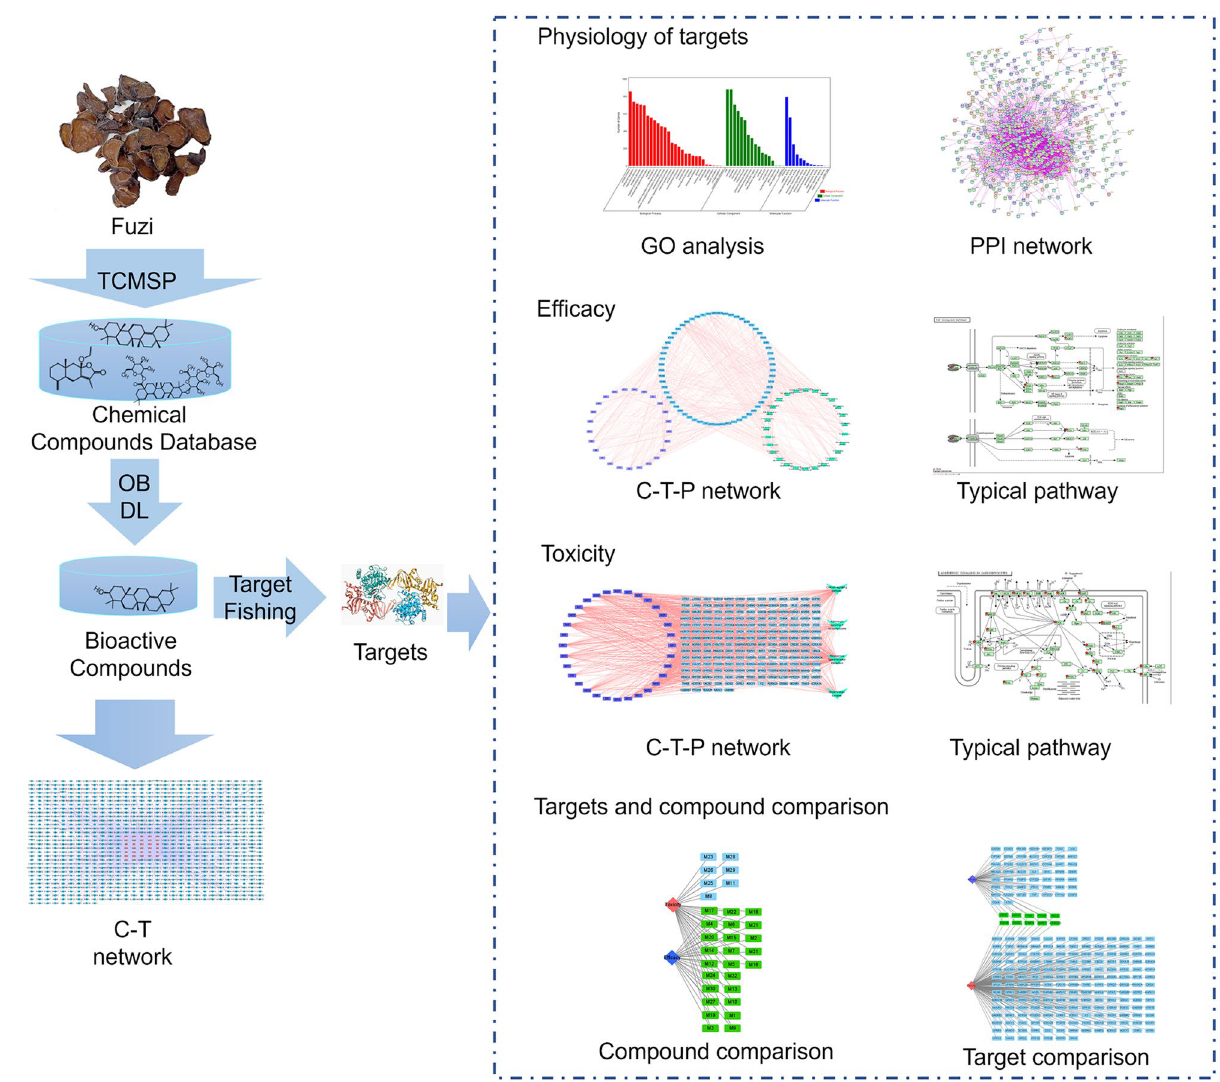
Figure 1. Schematic diagram of the systems pharmacology to comparatively investigate the efficacy and toxicity mechanisms of Fuzi. C-T compound-target, C-T-P compound-target-pathway, DL drug-likeness, Fuzi Aconiti Lateralis Radix Praeparata, GO gene ontology, OB oral bioavailability, PPI protein–protein interaction, TCMSP Traditional Chinese Medicine Systems Pharmacology Database and Analysis